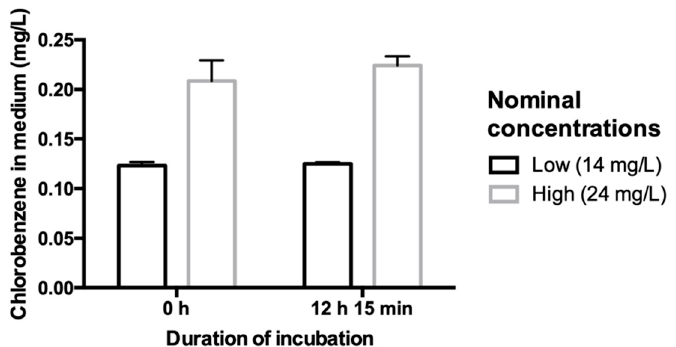
Figure 5. Barplots comparing chlorobenzene concentrations in test system medium, measured using Figure 5 . Barplots comparing chlorobenzene concentrations in test system medium, GC-MS, to assess whether any loss occurs over the test duration. At 0 h and after a 12 h 15 min exposure measured using GC-MS, to assess whether any loss occurs over the test duration. At 0 h period, two concentration groups ‘Low’ (nominal 14 mg / L) and ‘High’ (nominal 24 mg / L) test groups and after a 12 h 15 min exposure period, two concentration groups ‘Low’ (nominal 14 mg/L) were measured. Bars represent mean ± 1sd ( n = 4 per and ‘High’ (nominal 24 mg/L) test groups were measured. Bars represent mean ±1sd (n = 4 per group).